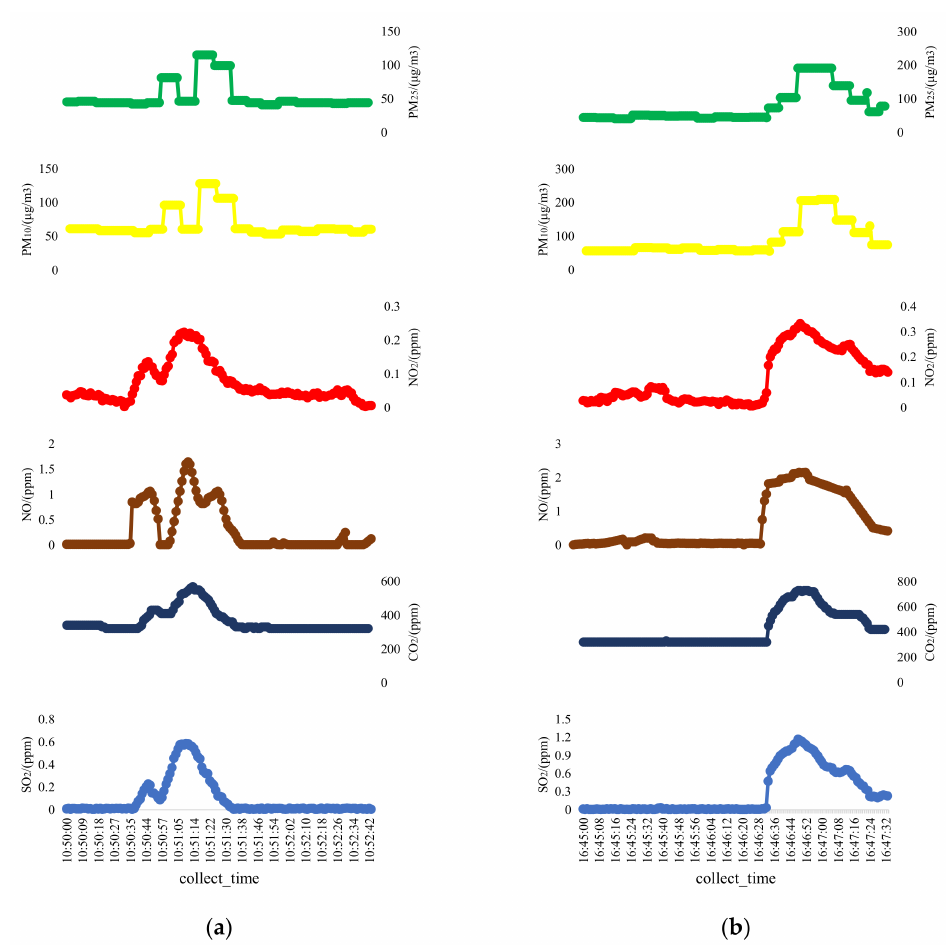
Figure 6. Measurements of typical plumes from two groups of ocean-going ships: ( a ) plume 1, ( b ) plume